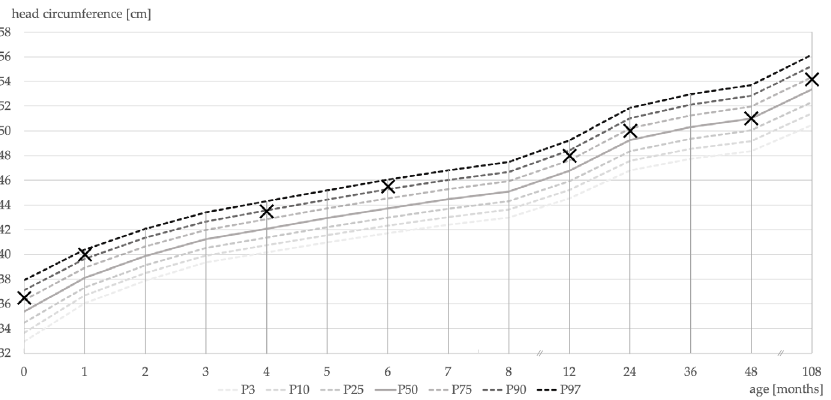
Figure 1. Percentile curves (P3–P97) of head circumference as a measure of dispersion. Crosses mark the patient’s measured head circumference during routine examinations. Patient’s head circumference was above the 50th percentile during his first 9 years of life.